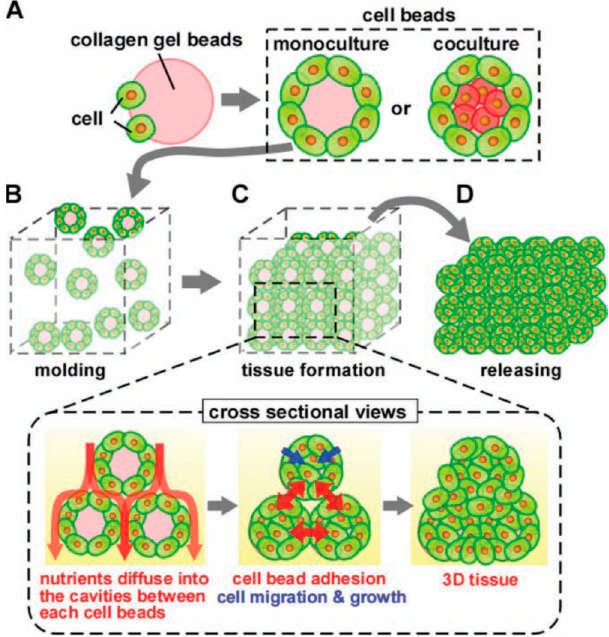
Figure 4. Concept of bead-based tissue engineering: Monodisperse cell beads are molded into a 3D tissue architecture [113]. (Reproduced with permission from Wiley.)